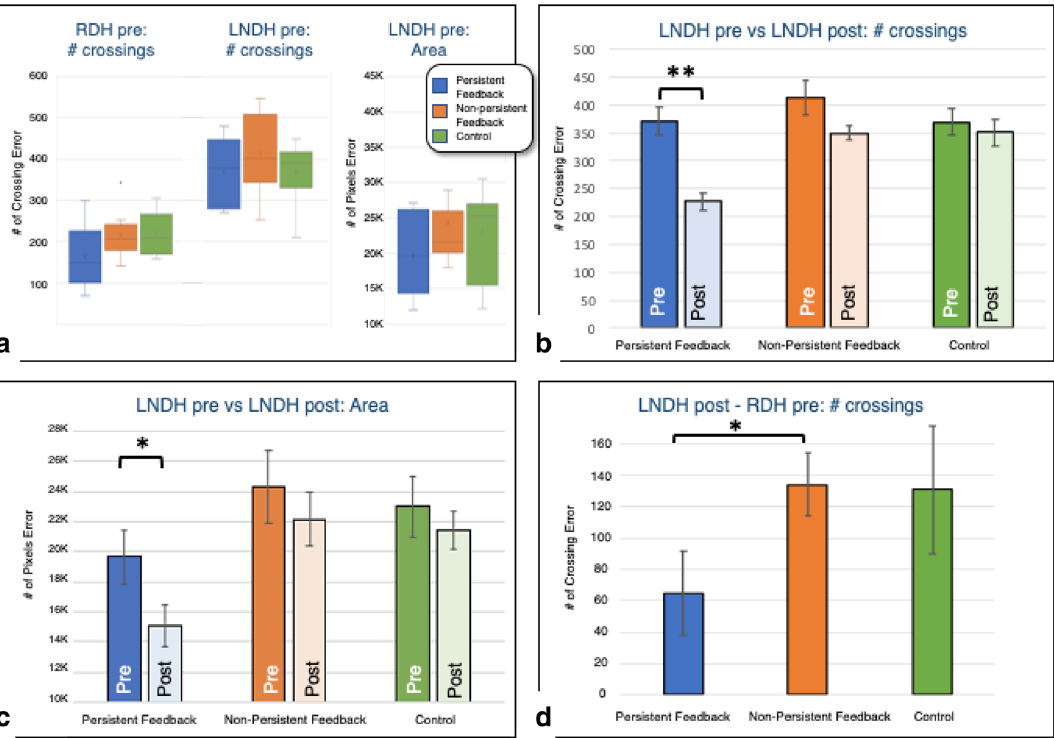
Figure 2. ( a ) Subjects were assigned to one of the three participant groups randomly: baseline tracing skill, quantified as the ‘number of crossing’ error pre-training, is comparable across subject groups for both the right- and left-hand, indicating no one group was biased with better pre-training skills. ( b , c ) The Persistent Feedback group is the only one that shows statistically significant tracing improvements as a result of their training regimen, for both the number of crossings error and the area metrics. ( d ) Difference between the LNDH Post-Training error and the RDH Pre-Training error shows that Persistent Feedback training is the only training regimen that leads to LNDH improvements that approach RDH baseline accuracy (i.e., mature tracing performance). Error bars indicate little steadier; 3: no difference between the steadiness of the tracings on the two sides; 4 right side tracing a little steadier; 5: right side tracing much steadier). After each rater had scored the entire set, their non-‘3’ responses (i.e. those which indicated a difference in steadiness between the two sides) were then compared to an answer key to determine whether or not the side they had selected as steadier was from the pre- or post-training period. Results